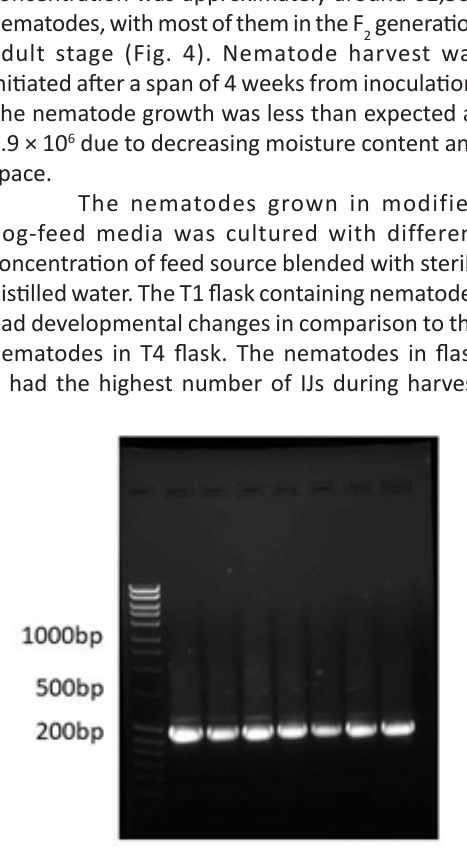
Fig.1a. PCR amplified products of isolated